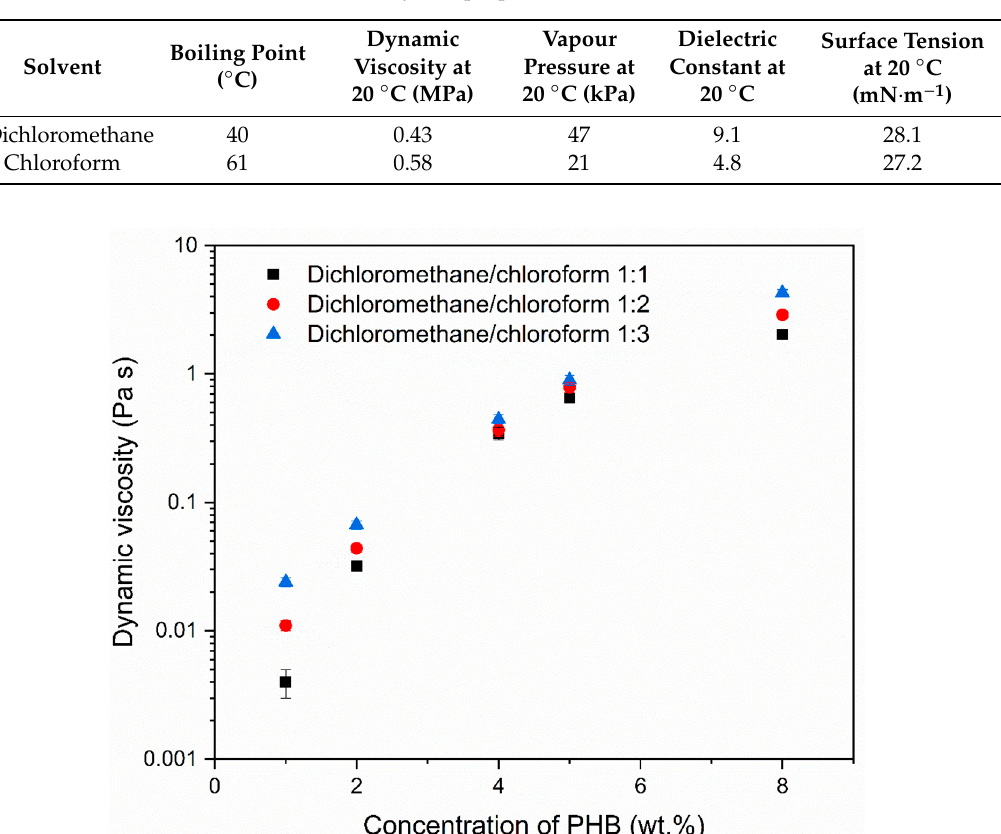
Figure 2. Dynamic viscosity of PHB solution in relation to the ratio of dichloromethane/chloroform